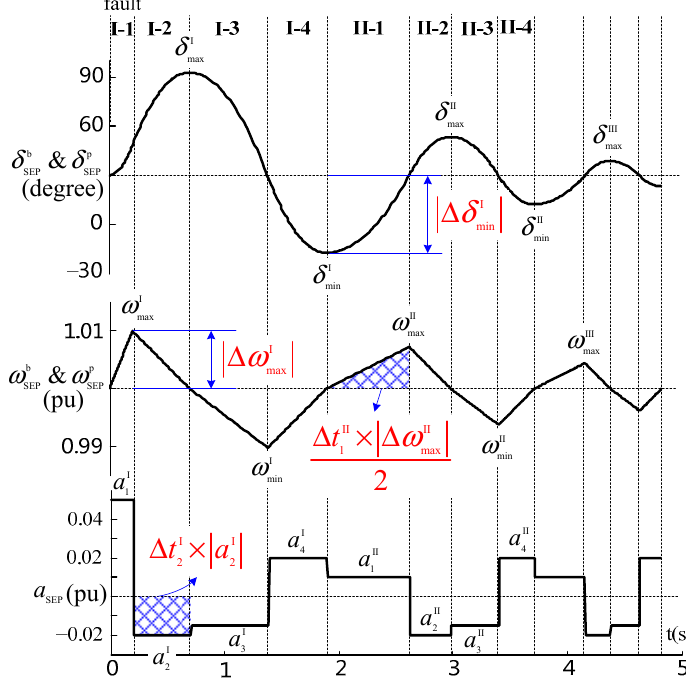
Figure 2. A typical swing process in a SMIB system. The pre- and post-fault SEP rotor angle is 30 degrees. Rotor acceleration during fault is 0.05 p.u. and lasts for 200 ms; rotor acceleration post fault is 0.01 p.u. in stage 1, − 0.02 p.u. in stage 2, − 0.015 p.u. in stage 3, and 0.02 p.u. in stage 4.